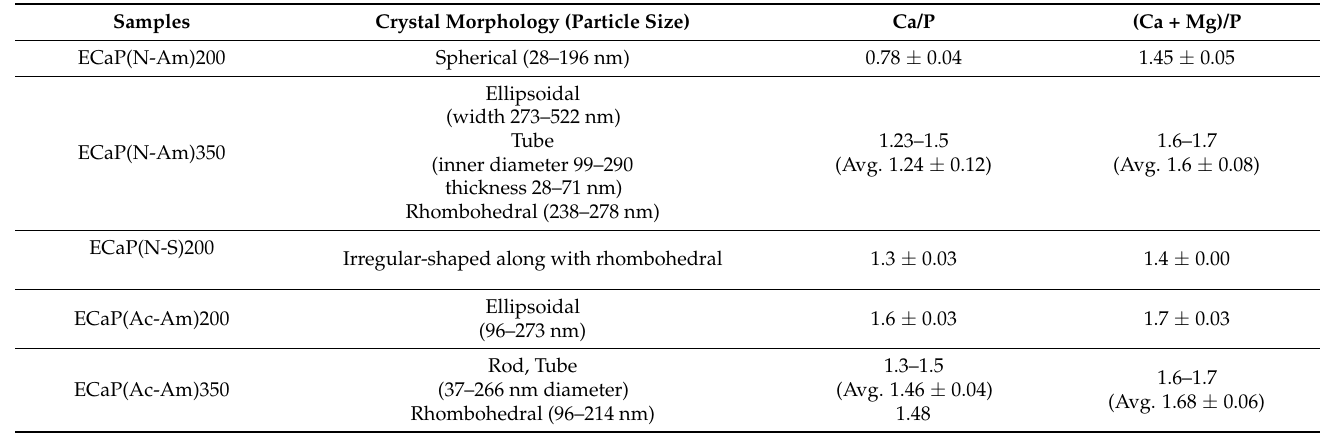
Table 7. The morphology including the particle sizes and the ratios of Ca/P and (Ca + Mg)/P of